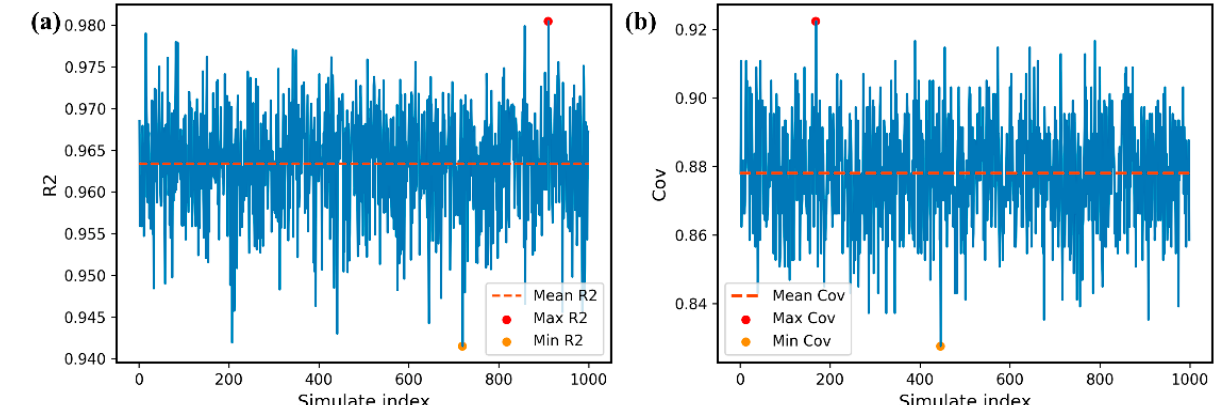
Figure 6. The evaluation of robustness using R 2 and Cov of predictive models. ( a ) The minimum, maximum and average values of R 2 are 0.941, 0.981 and 0.964, respectively; ( b ) The minimum, maximum and average values of Cov are 0.821, 0.922 and 0.878, respectively.